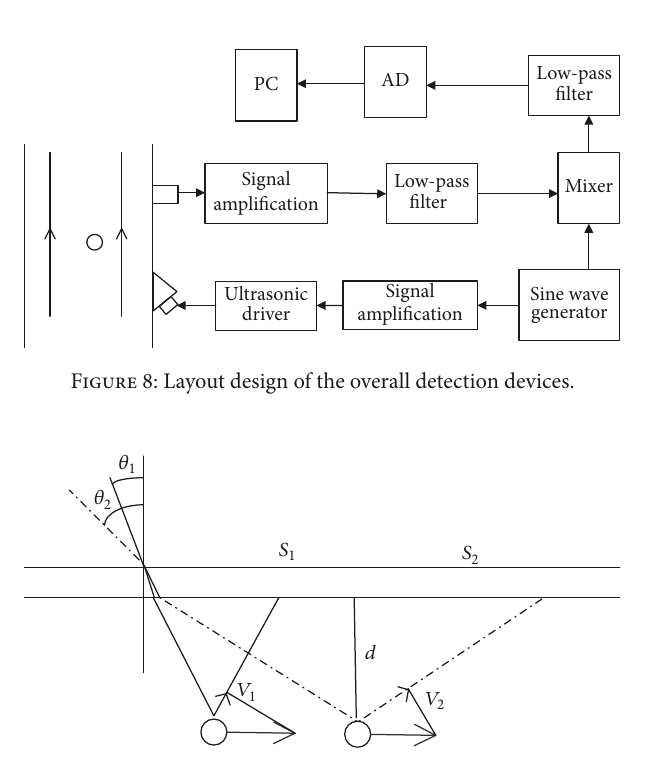
filtered and emitted signals into a compound signal with a frequency difference and a frequency sum. After entering into a low-pass filter with a cutoff frequency of 200 Hz, only the difference frequency signal will remain. Finally, after signal conditioning, the signal with Doppler frequency shift will be sent to a PC for storage and analysis by an A/D acquisition card ( 𝑓𝑠 = 100